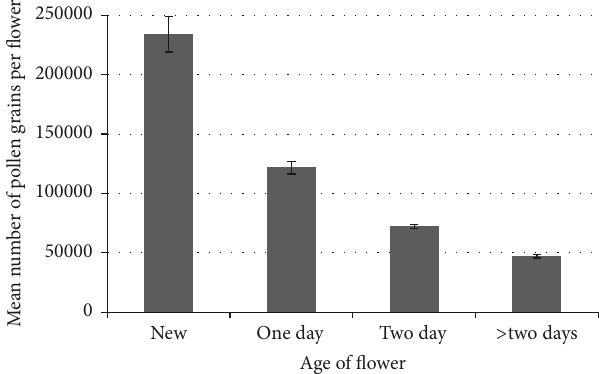
Figure 2: Number of pollen grains per anther with the age of flowers of different ages.